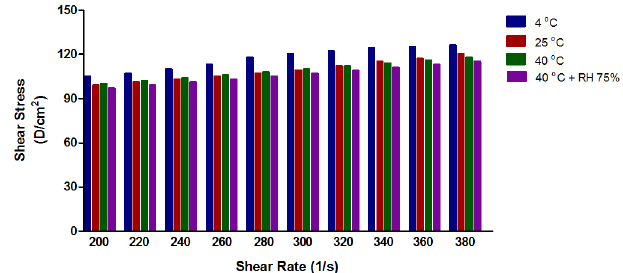
FIGURE 5 - Rheogram of control formulation at different temperature after 2 months. Temperatures tested were 8 o C (blue bars), 25 o C (red bars), 40 o C (green bars), and 40 o C + 75% RH (violet bars).